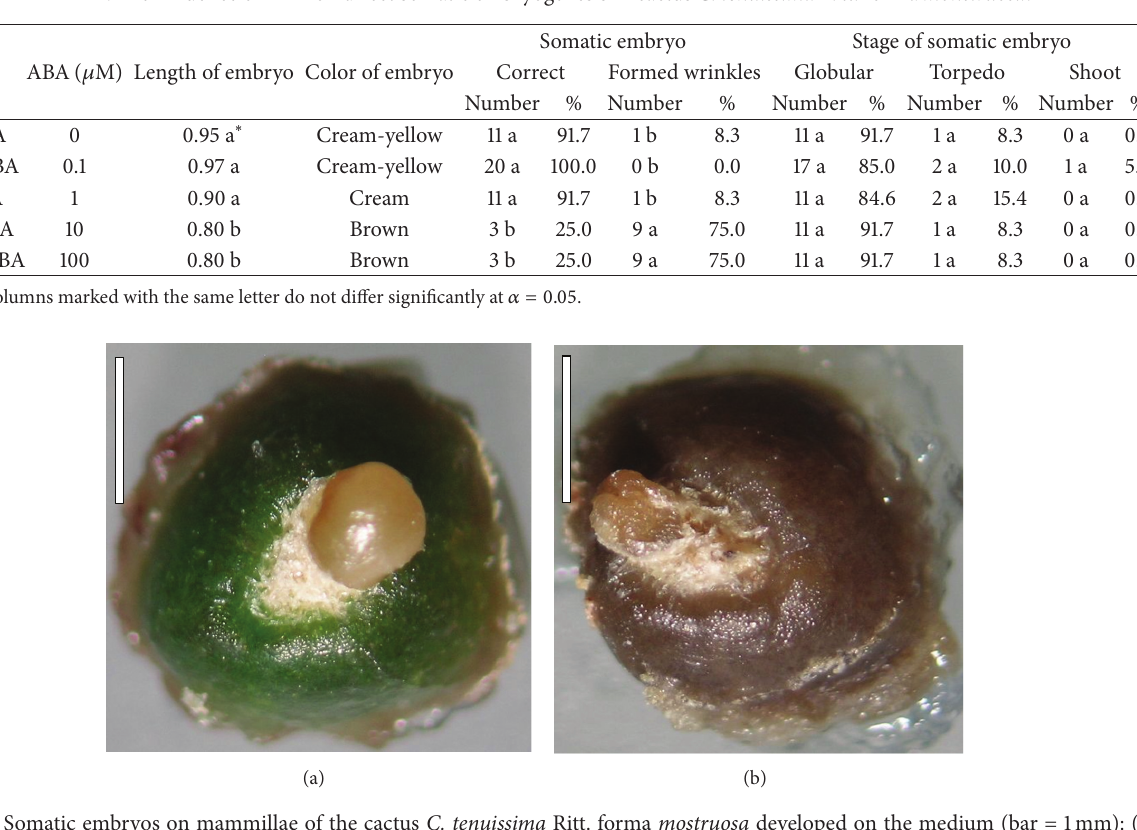
Figure 1: Somatic embryos on mammillae of the cactus C. tenuissima Ritt. forma mostruosa developed on the medium (bar = 1mm): (a) without ABA and (b) with a high concentration of ABA (10 𝜇